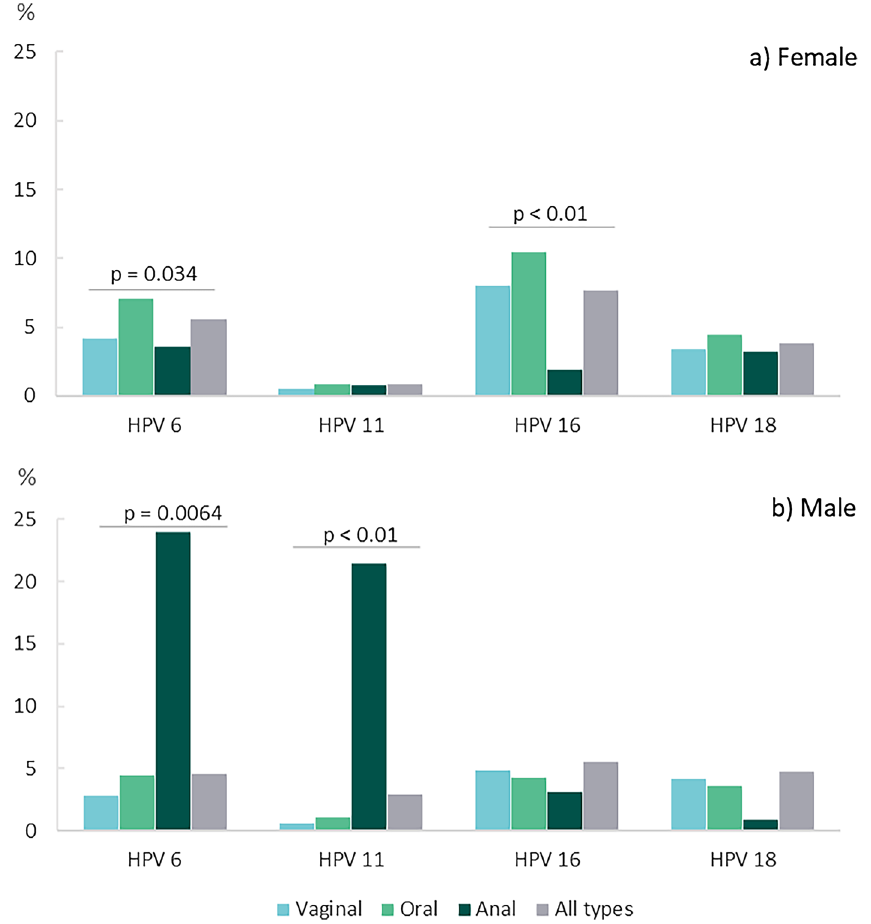
Figure 1. Prevalence of genital HPV types according to sexual practices in female and male types of sex practices (n =